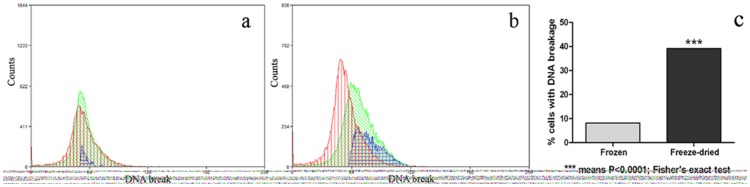
Occurrence of DNA damage in frozen and freeze-dried lymphocytes.(a) DNA breakage in fresh vs frozen lymphocytes and (b) in fresh vs freeze-dried lymphocytes. Left profile: red line = fresh (control) cell counts; green line = frozen lymphocytes cell counts; blue line = proportion of cells with damaged DNA. Right profile: red line = fresh (control) cell counts; green line = freeze-dried lymphocytes, cell counts; blue line; proportion of cells with damaged DNA. (c) Percentage of cells with DNA fragmentation (8.2% frozen and 39.2% freeze-dried cells with DNA damage) (p<0.0001, Fisher's exact test). DNA break of X-axis is the alpha t index.